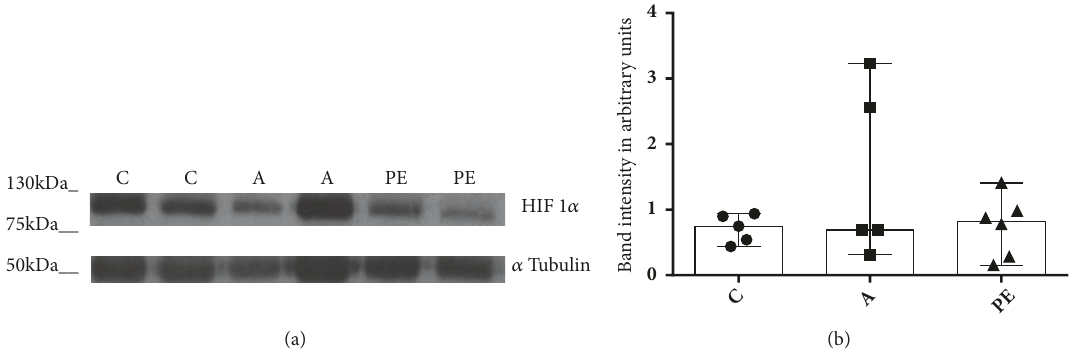
Figure 2: HIF-1 𝛼 expression in placental villi. (a) Representative image of a Western blot (an entire picture is presented in the supplementary figure 4B). (b) Expression of HIF-1 𝛼 in trophoblastic villi in the control group (C) n=5, the group with IDAP (A) n= 5 and the group with early-onset severe preeclampsia (PE) n=6. No statistically significant difference in protein expression between the three groups of women was observed. The data are shown as median and range, Kruskal-Wallis statistical